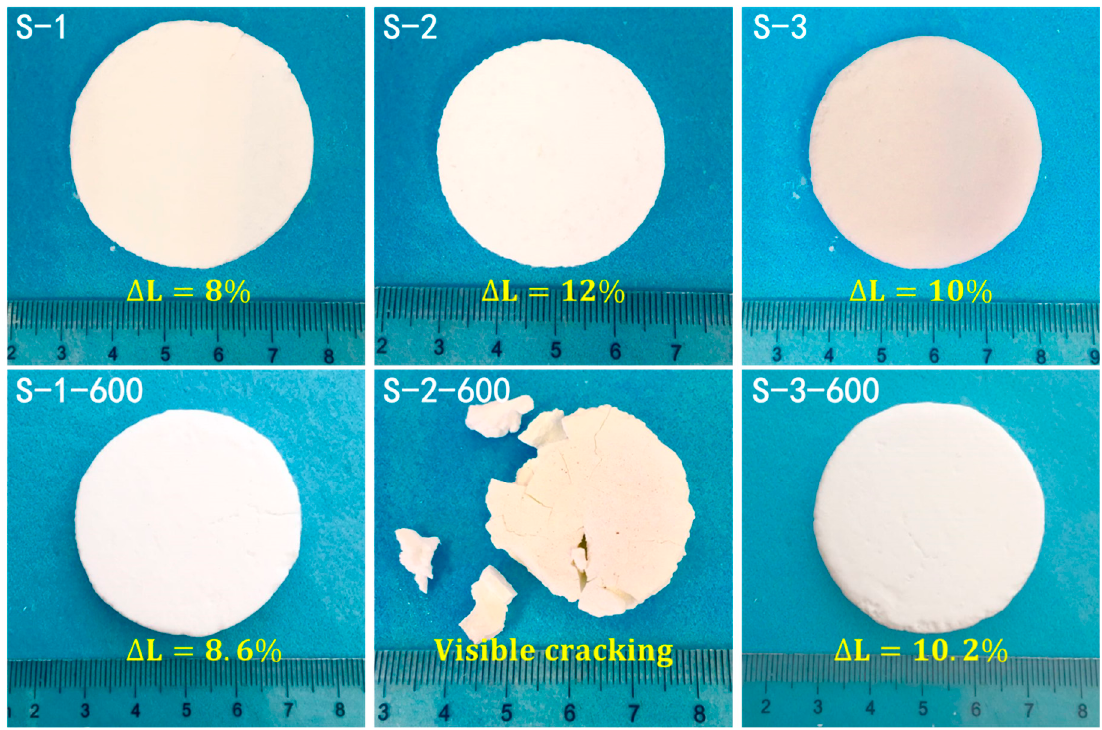
Figure 3. Photographs of silica aerogels prepared with different surfactants before and after heat treatment at 600 °C ( ∆L represents the linear shrinkage of obtained samples).